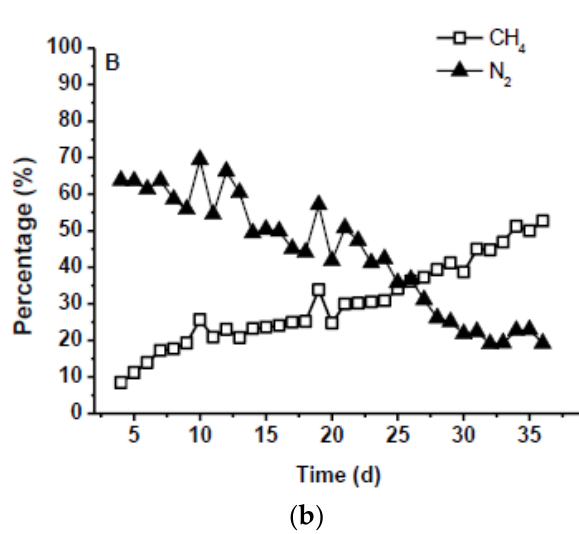
Figure 3. Biogas production ( a ) and biogas contents ( b ) of the preliminary SSAD study.